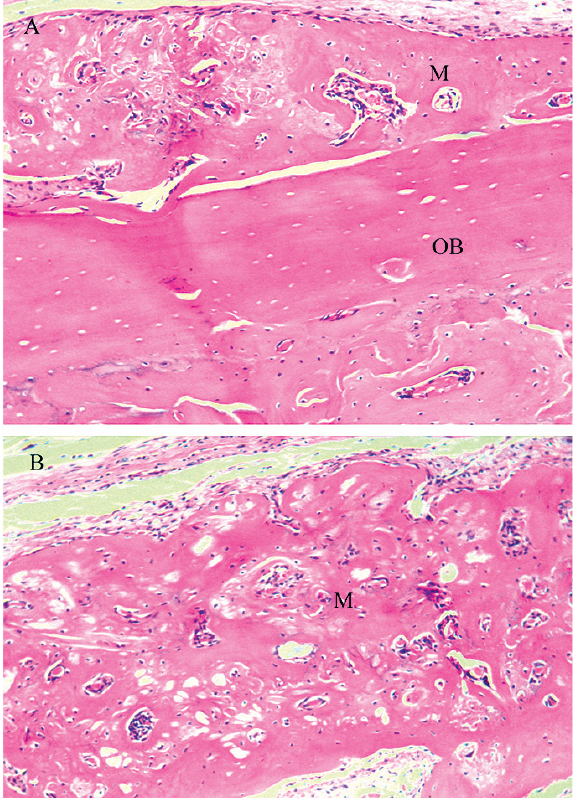
Figure 8- Group PBMT+M: A – Bone formation inside the membrane, membrane ossified (M), original bone (OB). B – Bone formation in the center of the defect (40x), ossified membrane